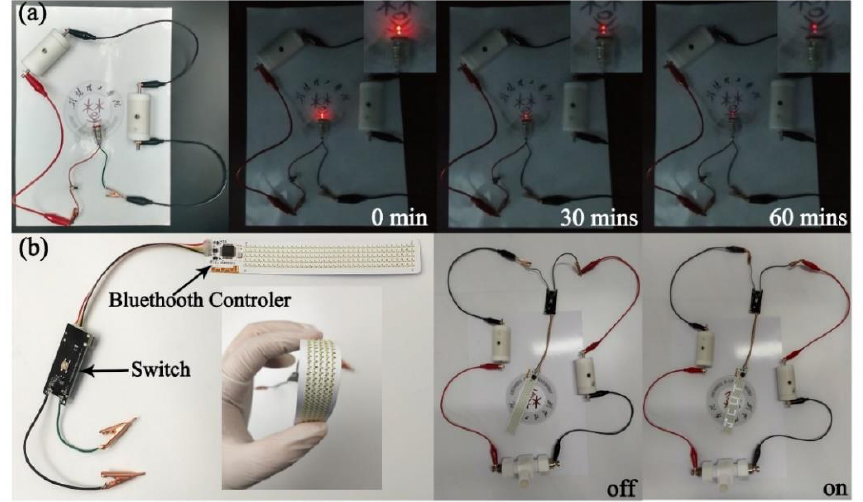
Figure 6. ( a ) Digital photograph of lighting the red lamp (2.5V) powered by two SSCs in series for more than 60 min; ( b ) photo of the flexible LED lamp band that was powered by three SSCs in series.